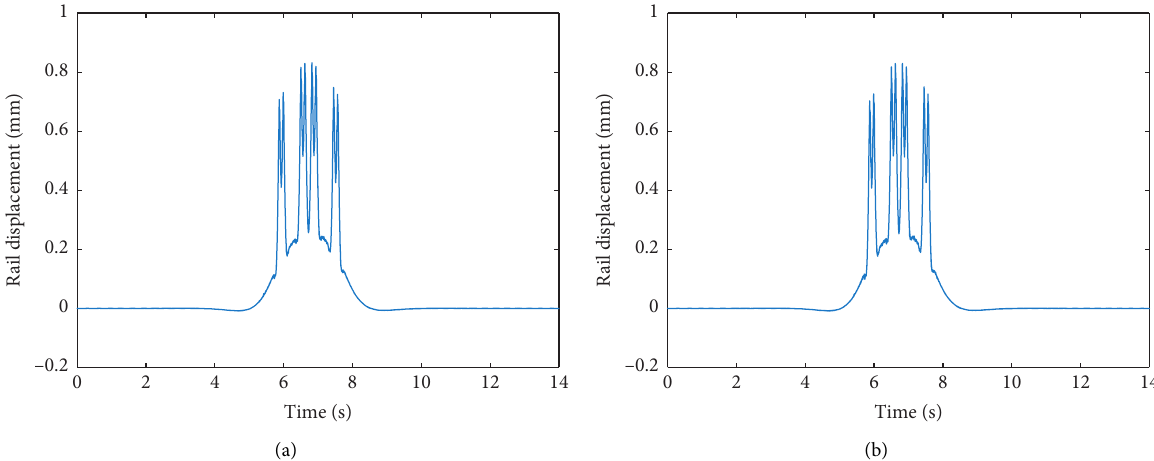
Figure 7: Effect of tunnel differential settlement on the vertical displacement at the midpoint of the rail. (a) Without differential settlement. (b) With differential settlement.